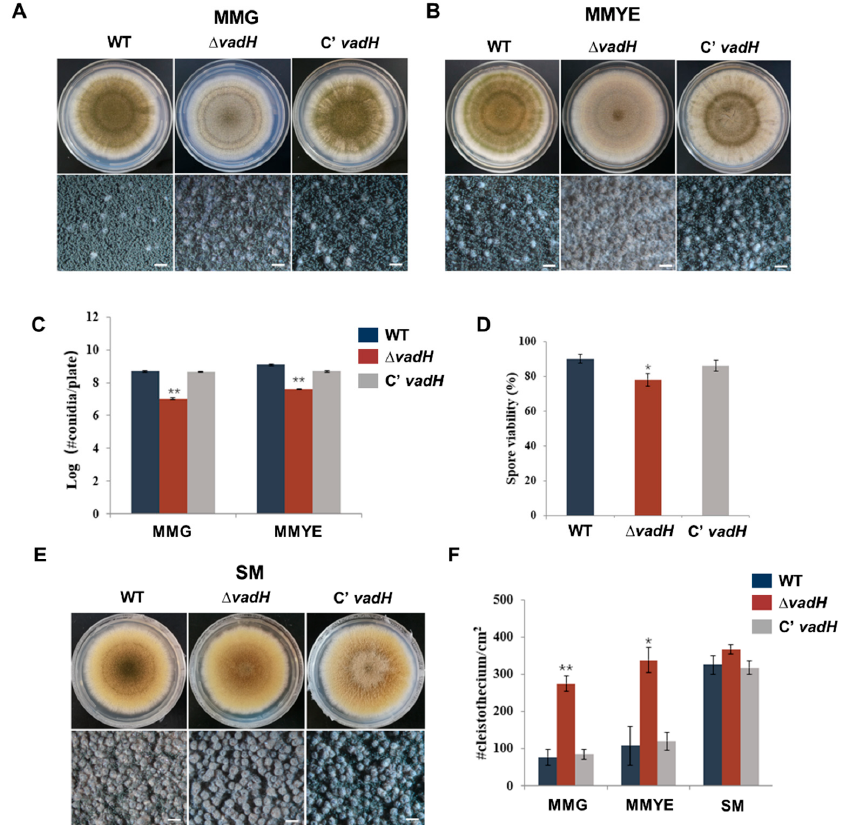
Figure 3. Developmental phenotypes of the Δ vadH mutant. ( A , B ) Colony morphology of WT, Δ vadH , and the complemented strain on MMG ( A ) or MMYE ( B ) and grown for 7 days. The bottom panel shows close-up views of the colony in the top panel (Bar = 0.5 mm). ( C ) Statistical analyses of conidial yields on MMG and MMYE. ( D ) Statistical analyses of spore viabilities. ( E ) Colony morphology of WT, Δ vadH , and the complemented strain on SM and grown for 7 days. The bottom panel shows close-up views of the colony in the top panel (Bar = 0.5 mm). ( F ) Statistical analyses of cleistothecia on MMG, MMYE and SM. The asterisks represent significant level (* p < 0.05, ** p < 0.001).